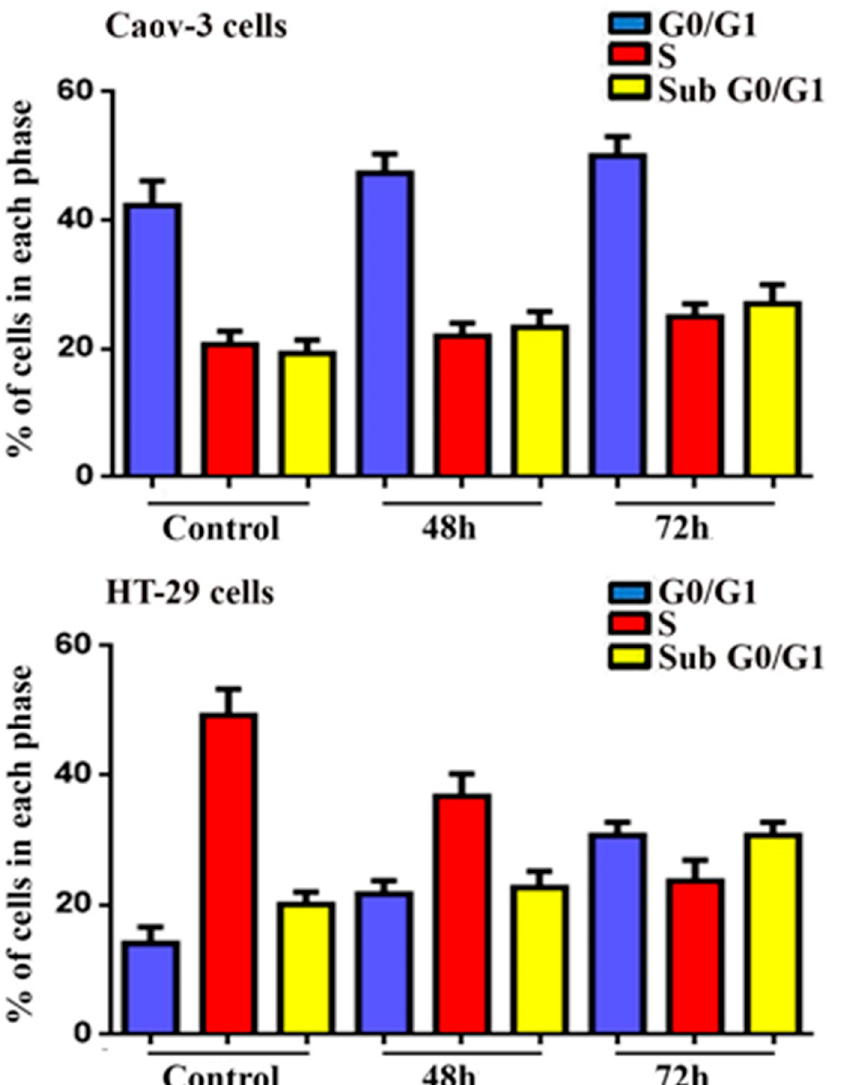
Figure 6. Cell cycle analysis of Caov-3 and HT-29 cell line after treatment with platinum(II) complex at different times as indicated. Bars show mean ± SEM.